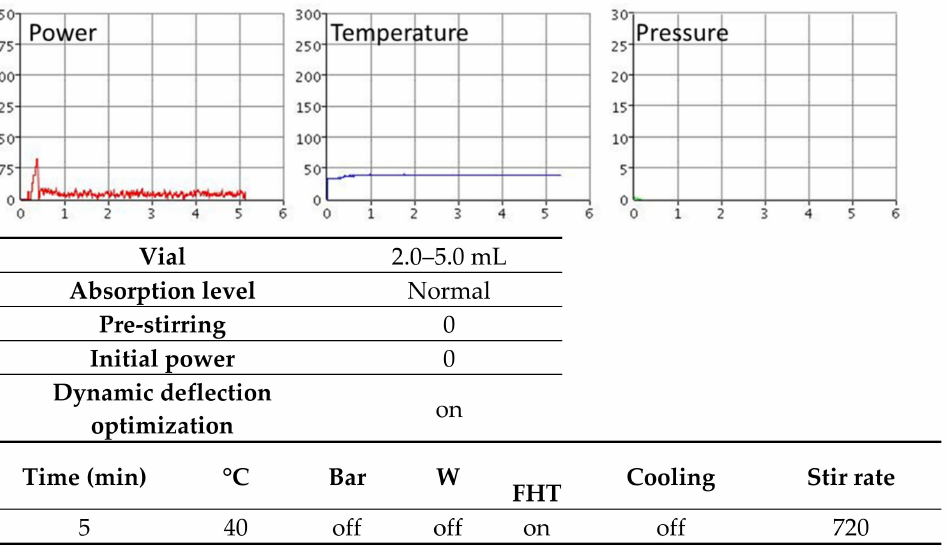
Figure 3. MW assisted S-alkylation of peptide 6a